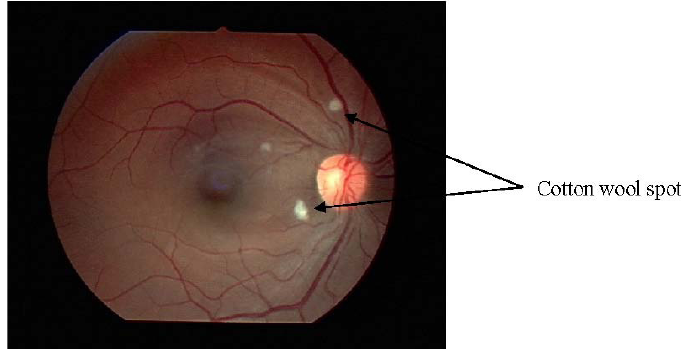
Figure 1. Cotton wool spots (Photo courtesy of Dr Linda Visser) Retinal